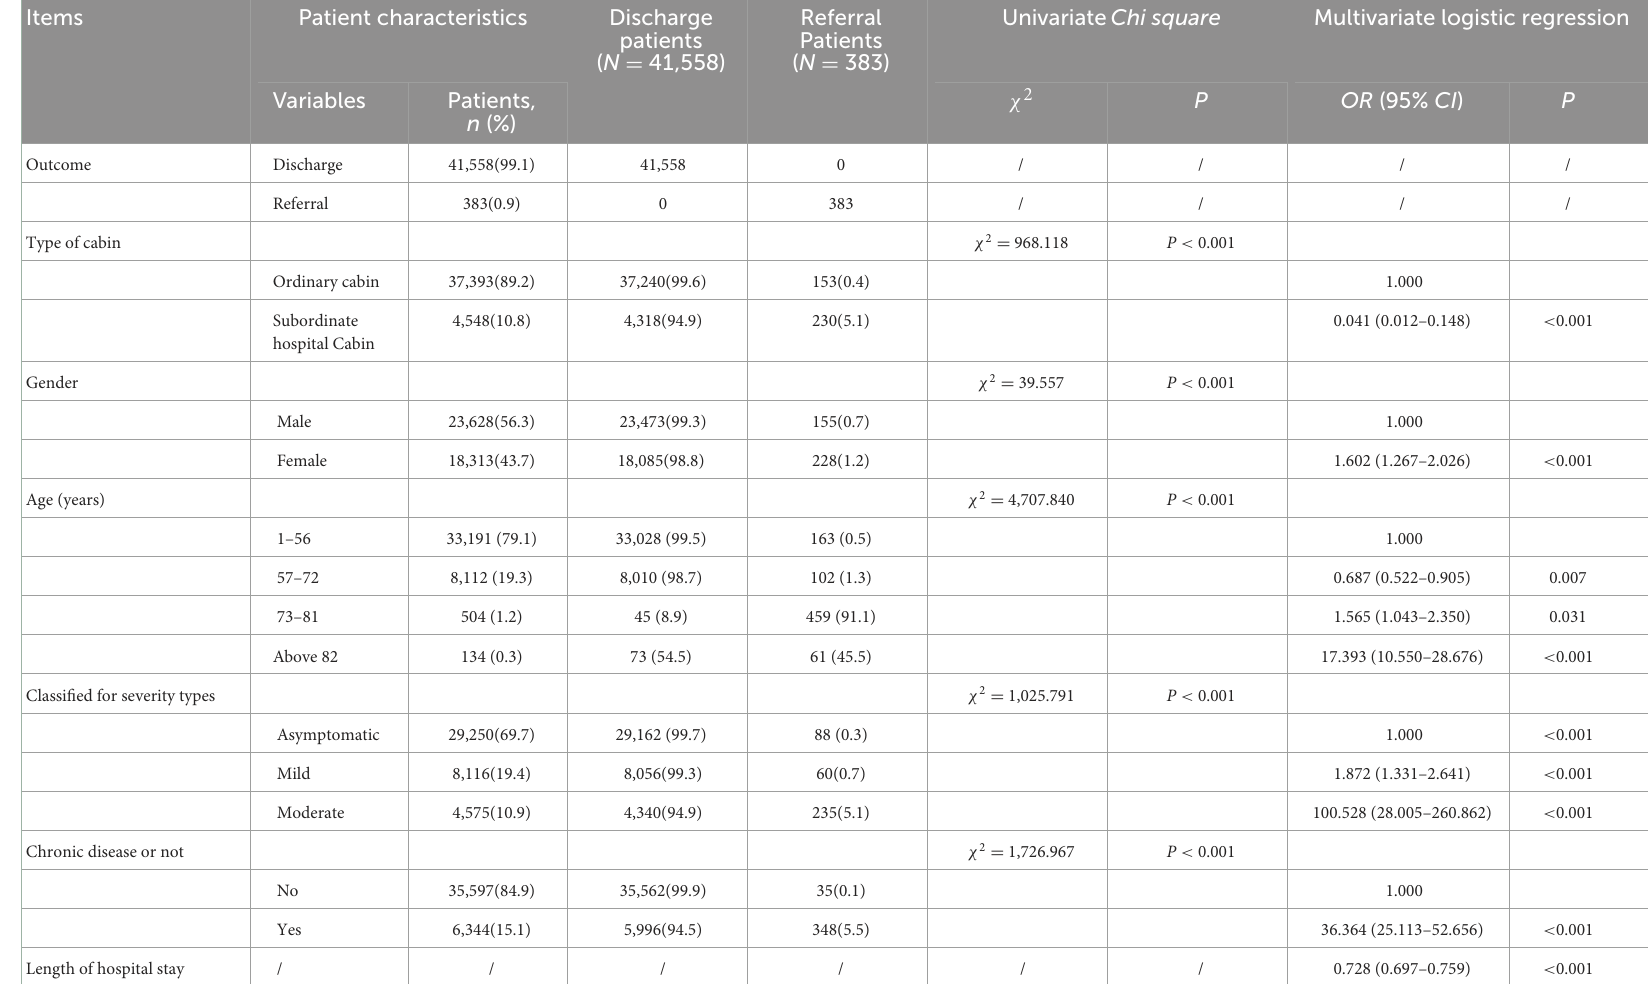
TABLE 1 Patient characteristics, univariate and multivariate logistic regression analysis of factors related to the outcome of COVID-19 patients in SNIEC makeshift